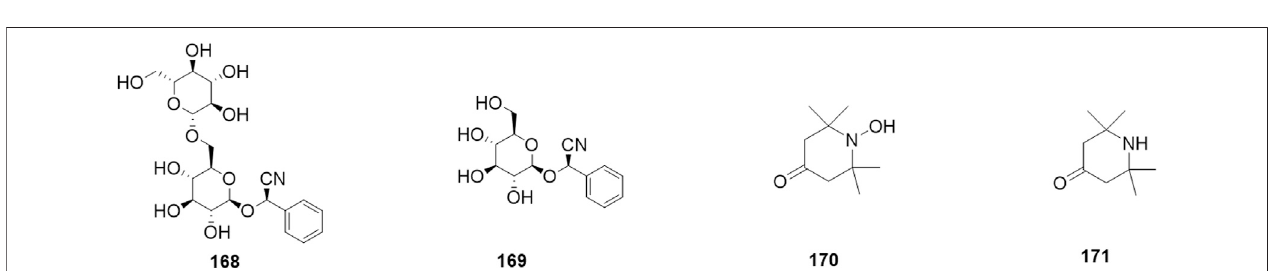
Frontiers in Pharmacology |